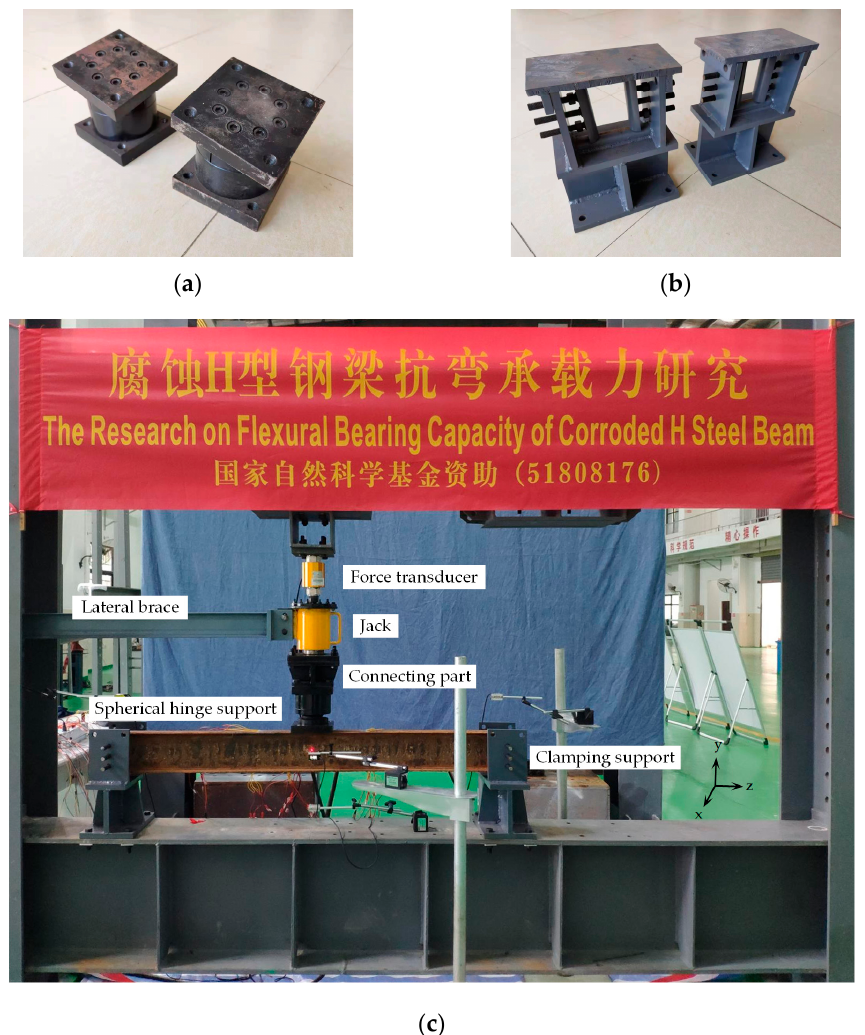
Figure 6. Components and loading equipment used for the overall stability test: ( a ) Spherical hinge support; ( b ) Clamping support; ( c ) Loading.